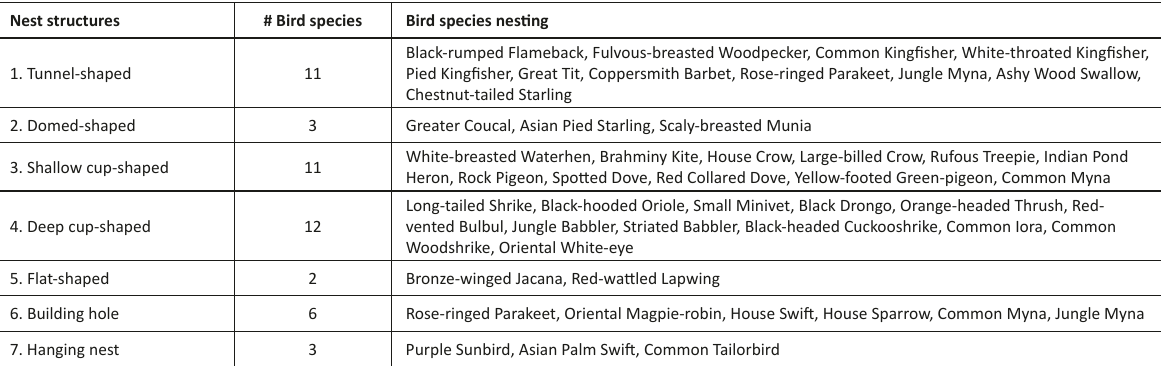
Table 1. Nest structures recorded in different bird species Nest